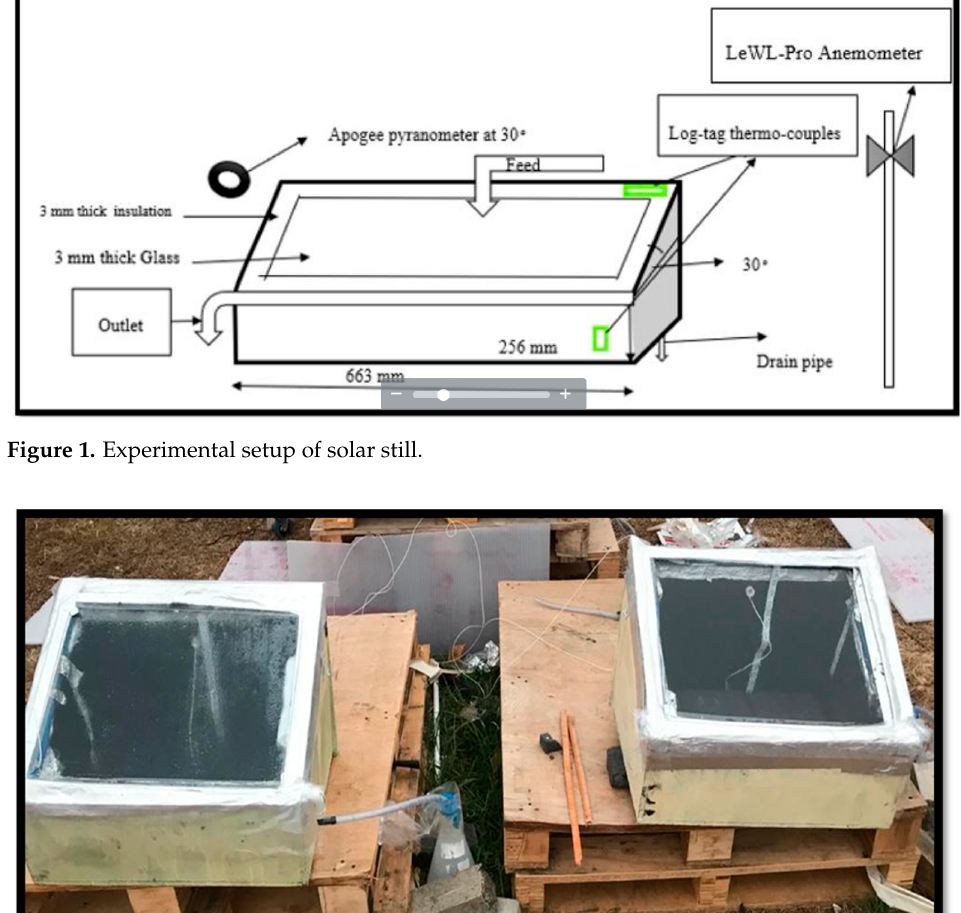
Figure 1. Experimental setup of solar still.